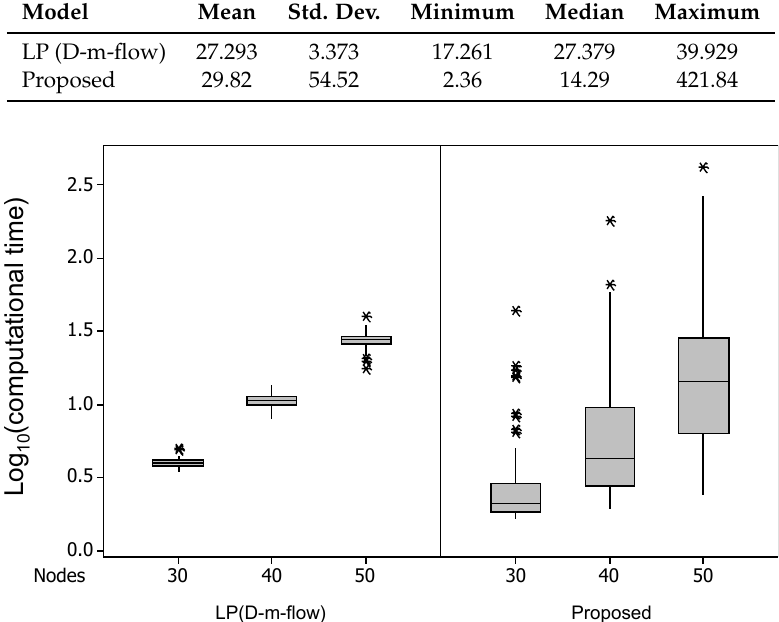
Figure 6. Box and Whisker plots for the distribution of computational times in seconds of the LP relaxation of the D-m-flow model and the proposed model for the 30-, 40- and 50-node instances. For the 50-node instances, the proposed model achieved less computational times in 74